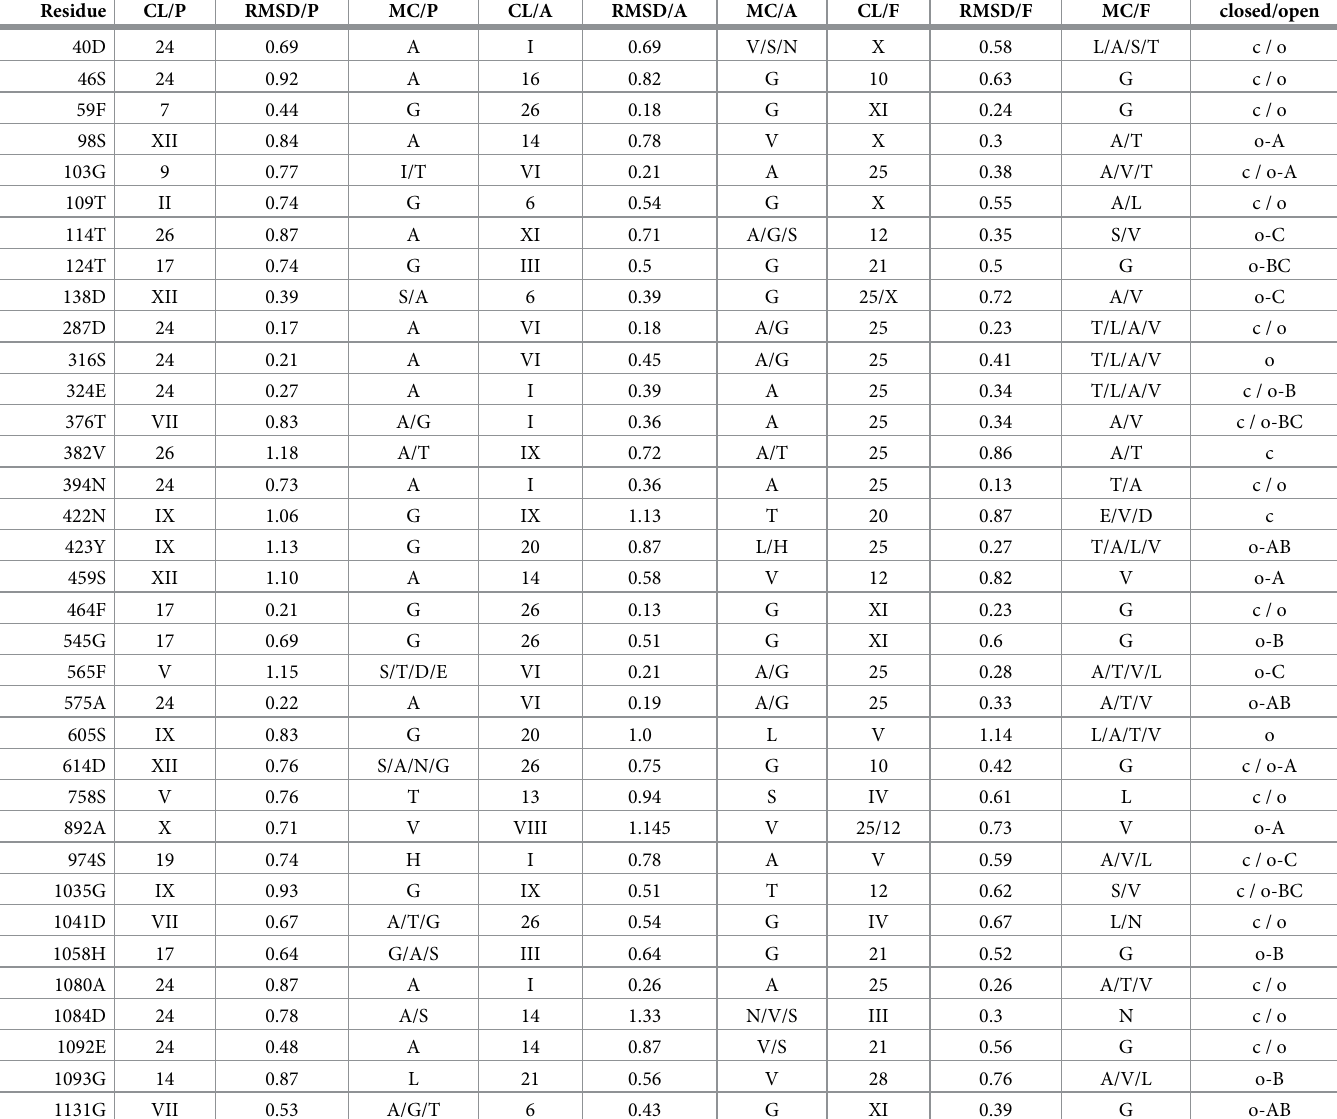
Table 1. Flattening points in spike protein PDB structures 6VXX and 6VYB. Columns are organized as follows: Residue number with present amino acid. CL stands for cluster with smallest RMSD (in Å ); clusters are taken from [41]. MC stands for most common mutagenic amino acid substitutions in the cluster. P stands for preceding, A stands for adjacent and F stands for following fragment. Closed (c) and open (o) denotes the state where flattening point is observed. A,B,C denotes the monomer of spike